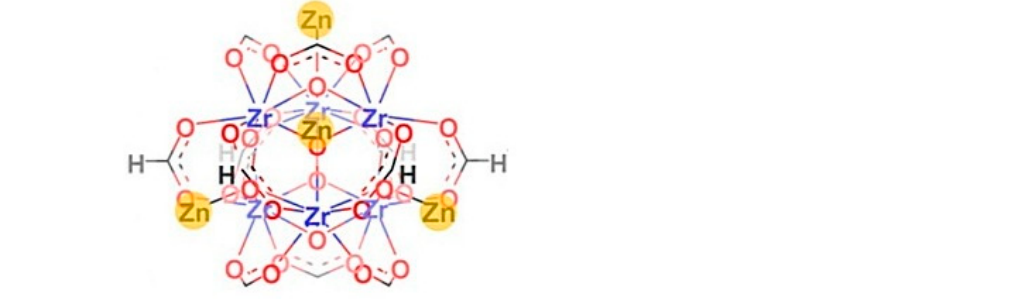
Figure 20. Zn-Zr cluster in the MOF-808-Zn catalyst for CO 2 hydrogenation (Zhang J. et al., 2021) [197].